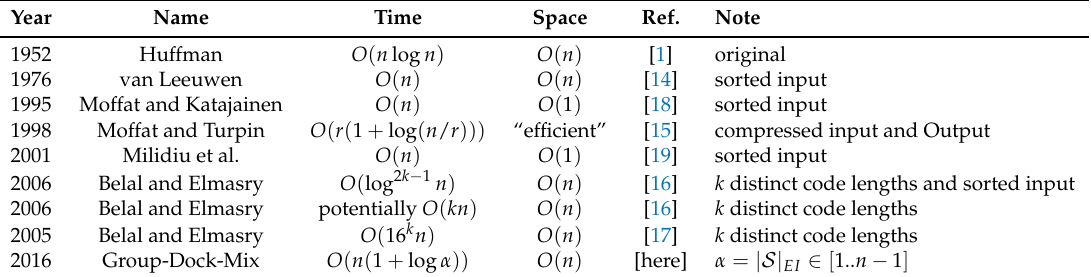
Table 1. A selection of results on the computational complexity of optimal prefix free codes. n is the number of weights in the input; r ∈ [ 1.. n ] is the number of distinct weights in the input; k ∈ [ 1.. n − 1 ] is the number of distinct codelengths produced; and α ∈ [ 1.. n − 1 ] is the difficulty measure introduced in this work, the number of alternation between External nodes and Internal nodes in an execution of the algorithm suggested by Huffman [1] or by van Leeuwen’s algorithm [14] (see Section 3.1 for the formal